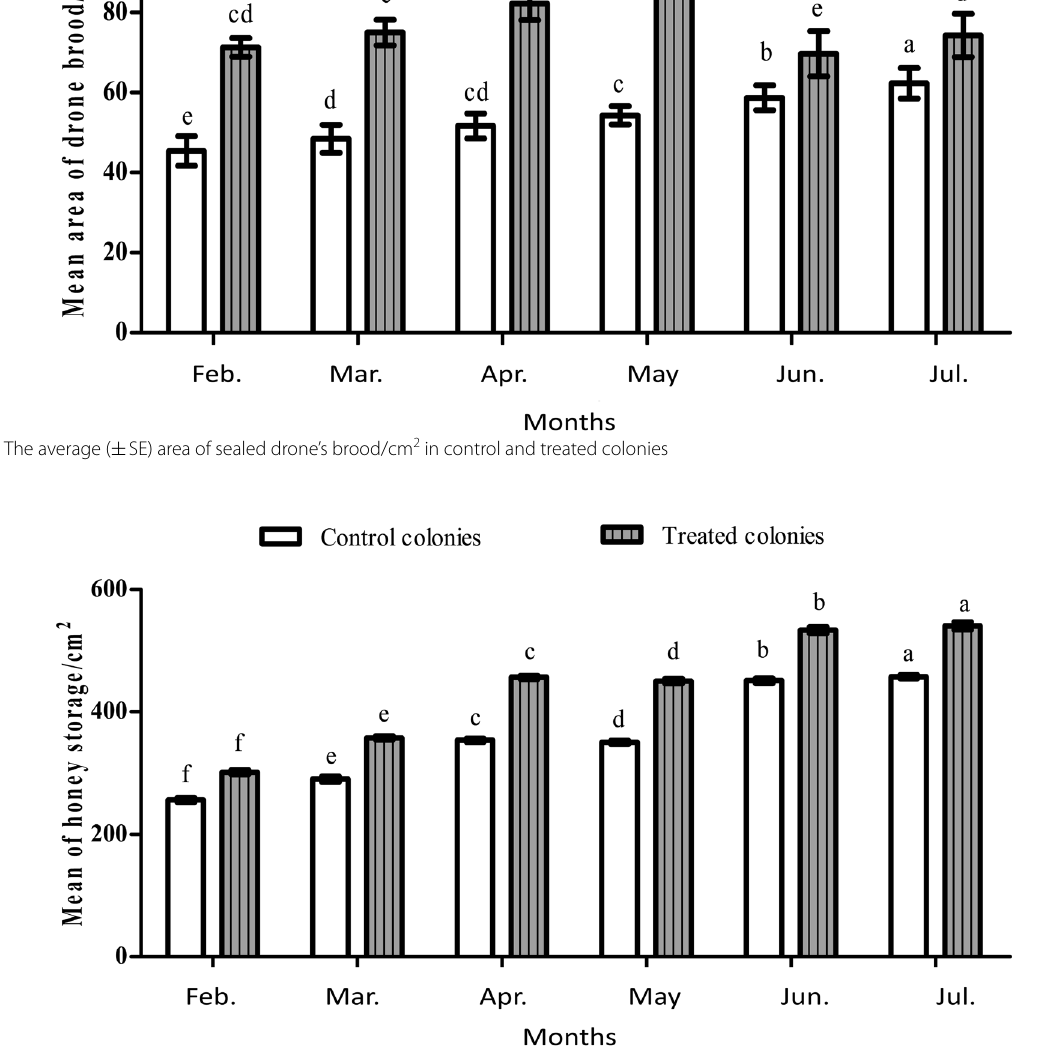
Fig. 3 The average ( SE) of stored honey /cm 2 in control and treated ±